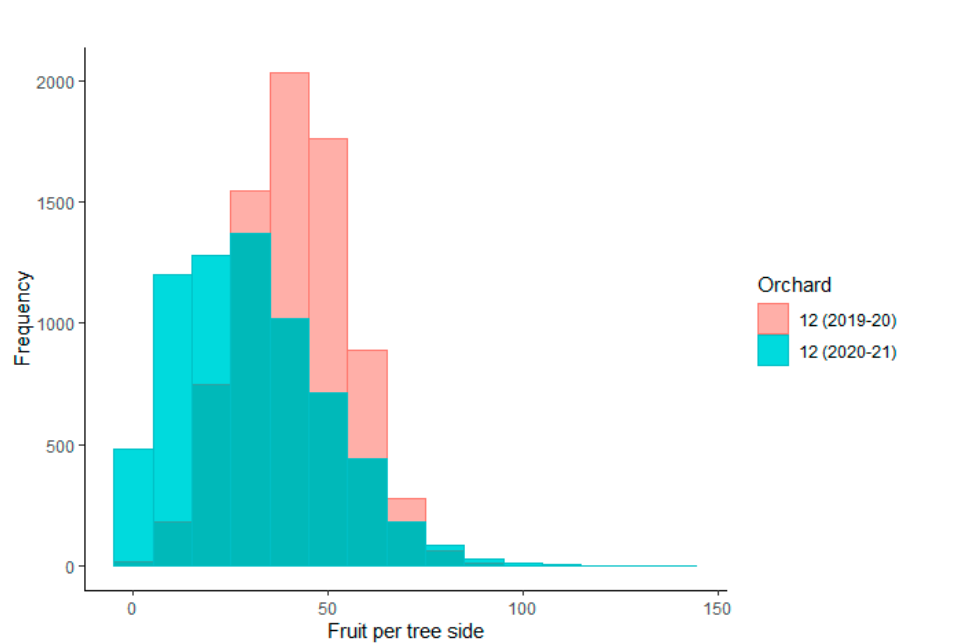
Figure 8. Frequency distribution for tree fruit load for tree side of orchard 12 in 2019–20 and 2020–